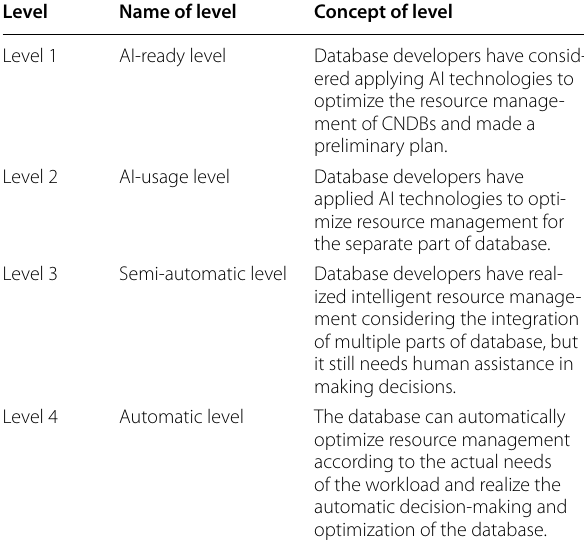
Table 8 The maturity level identified from our study and